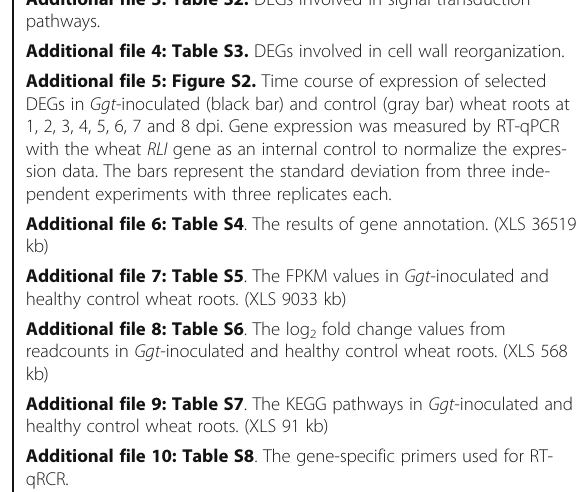
Additional file 1: Table S1 . Summary of RNA-Seq data sets.